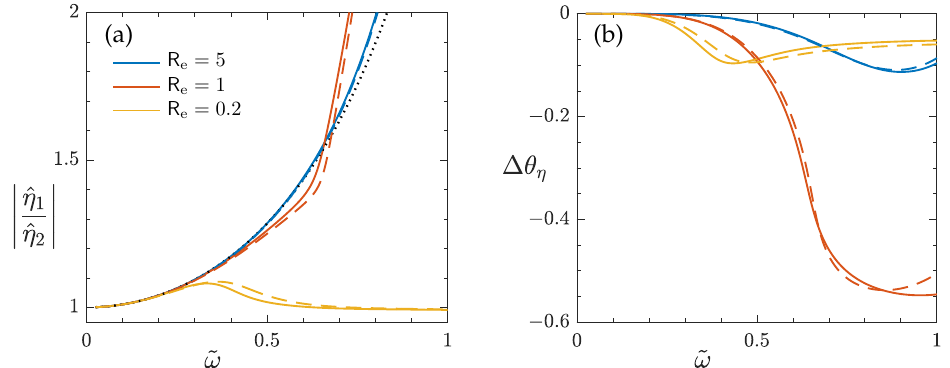
Figure 6. ( a ) Ratio of wave amplitude at the upper surface to that at the interface, difference between the waves, ∆ θ η = θ η case of two inviscid fluids, Lamb’s solution of are in-phase; i.e., ∆ θ η =